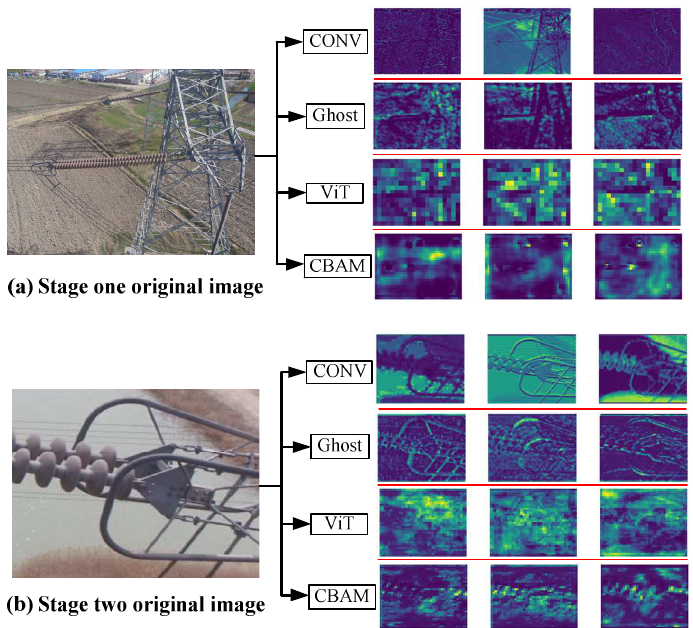
Figure 17. Double-attention YOLO network main module feature extraction visualization results.